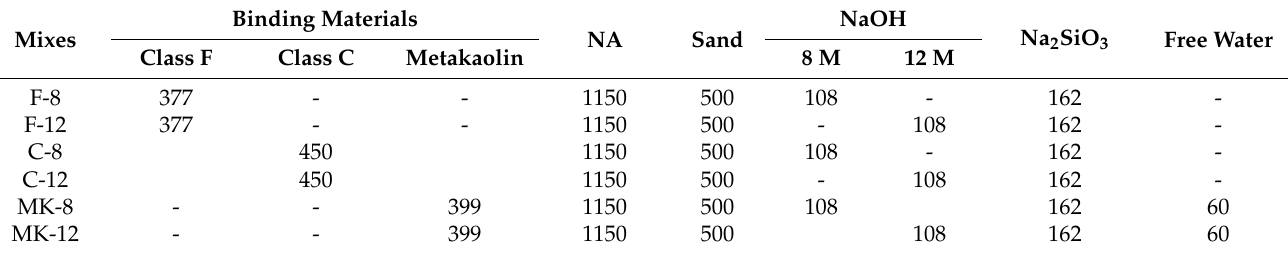
Table 2. Proportions of mixtures (kg/m 3